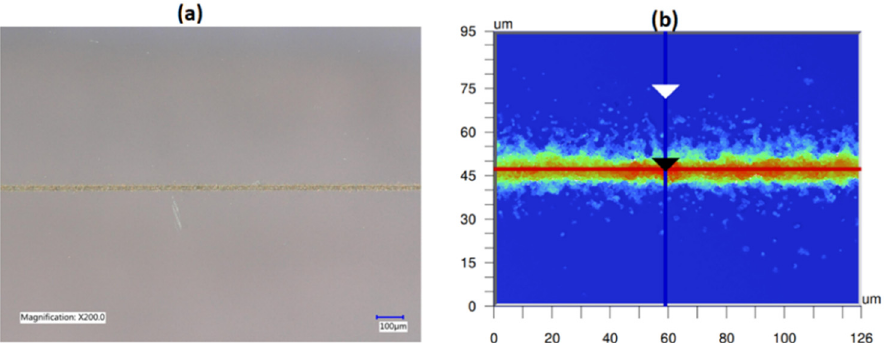
Figure 5. Different methods of measurement compensate for irregularities or show them (Clariant Prelect TPS50). ( a ) optical microscopic picture and ( b ) profilometer scan.